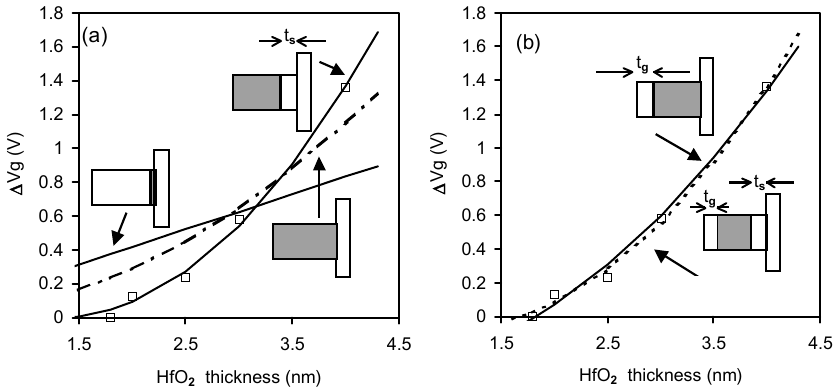
Figure 39. The location of as-grown electron traps in HfO 2 . Symbols represent the test data, and the lines are fitted with traps located in the grey regions [63].